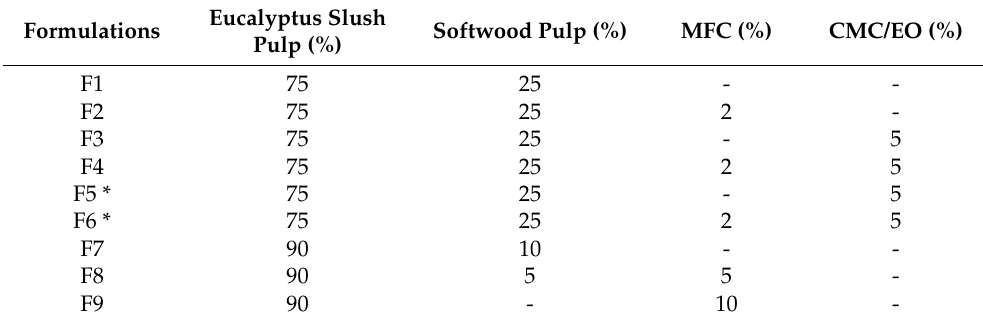
Table 1. Description of the formulations used in the studies.